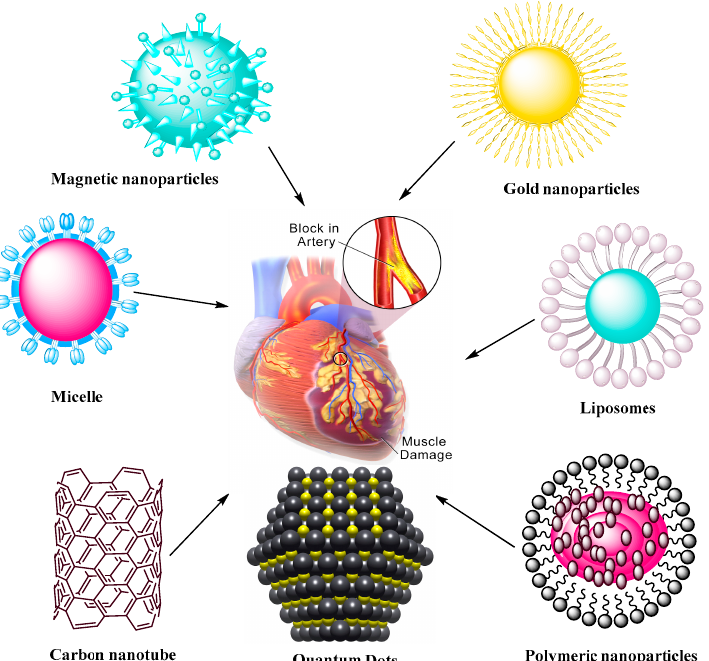
Figure 4. Nanoparticle-mediated drug delivery systems to target CVDs. The systems include magnetic and AuNPs, self-assembling micelles, liposomes, carbon nanotubes, quantum dots, and polymeric NPs formed via assembly of polymers containing therapeutic agents.